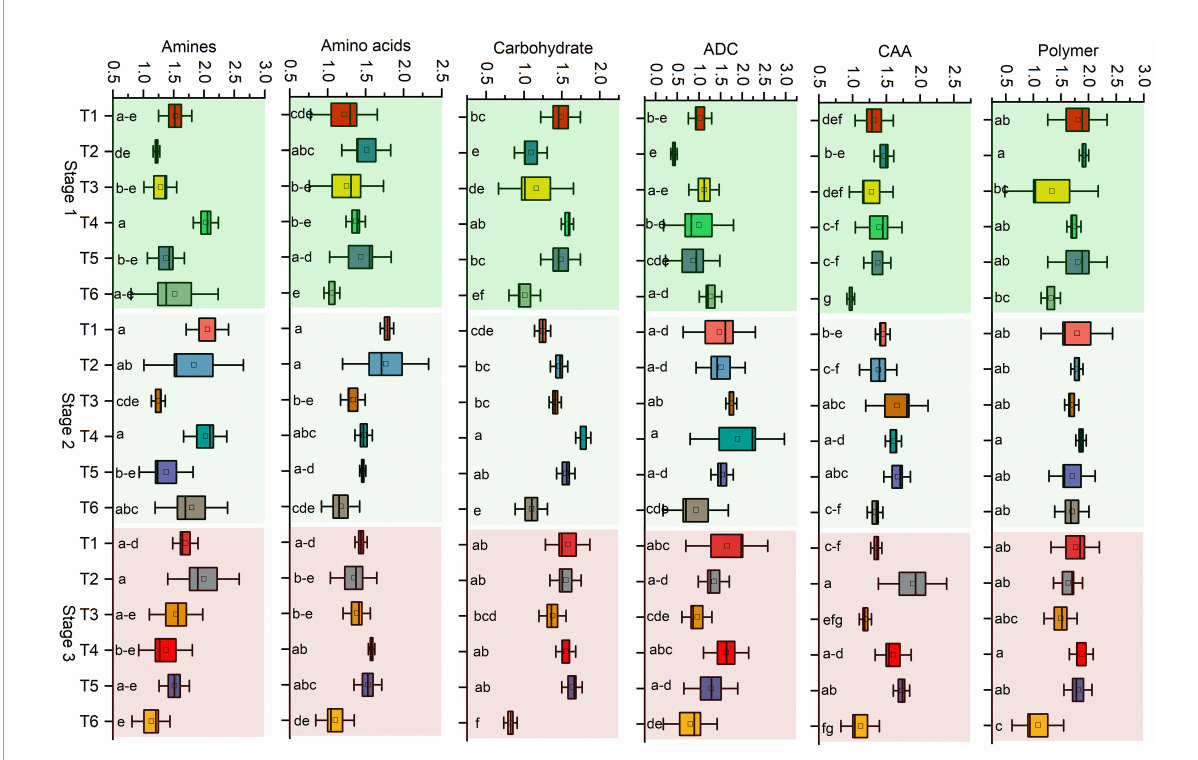
FIGURE5 Community-level physiological profiles (CLPP) of pathogen and antagonist treated soil samples. Substrates were classified as amines/amides, amino acids, carbohydrates, Acids derived from carbohydrates (ADC), Carboxylic & acetic acids (CAA), and polymers. Mean values ( n = 3) in the same column followed by the same letter(s) are not significantly different at ( P < 0.05) according to the DMRT test. Treatment details as Figure 2